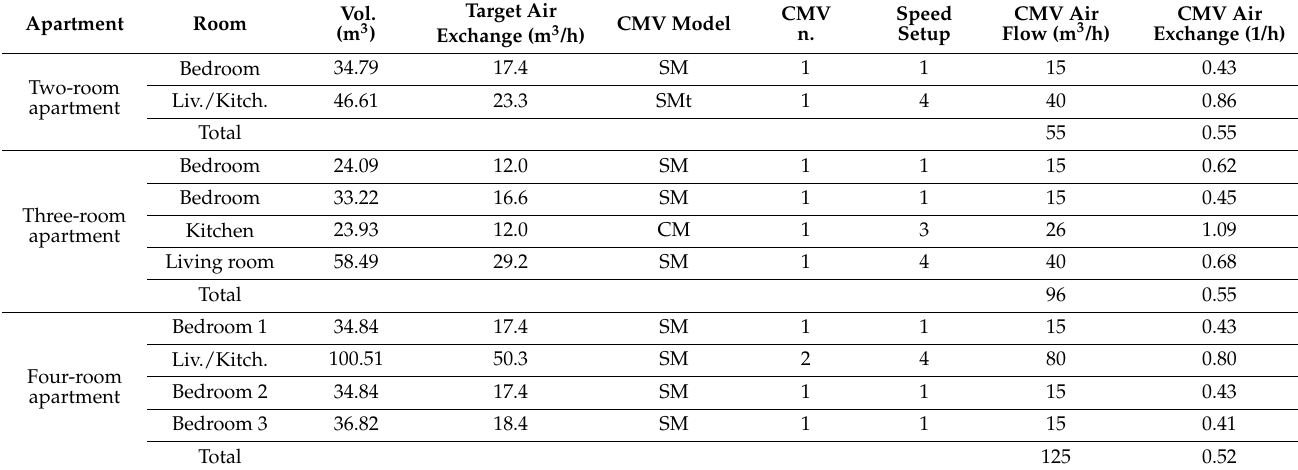
Figure 5. Four-room apartment plan. Table 3. “Night” configuration.